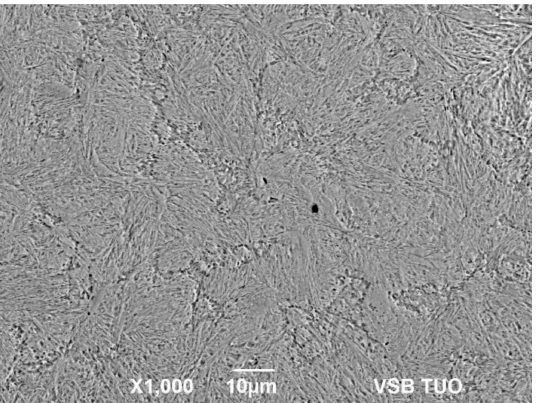
Figure 11. Metallographic image with uncertain etched boundaries of the original austenitic grains . ε = 20 s − 1 , ε = 0.16. of steel D— T d = 1100 ◦ C,